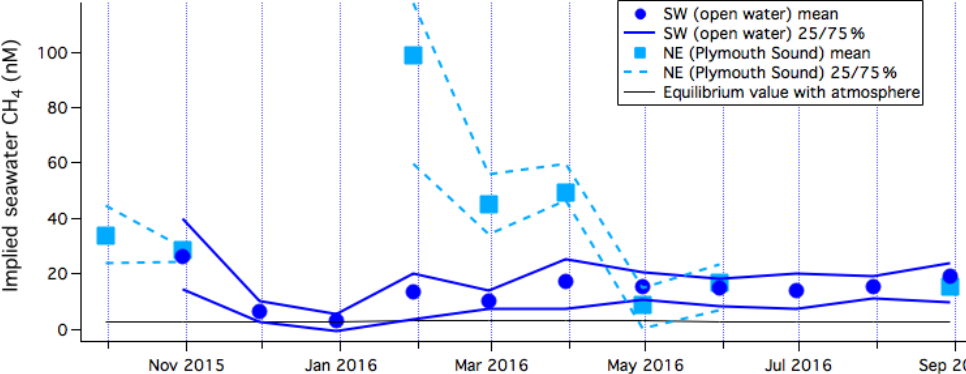
Figure 3. Monthly averages and 25th and 75th percentiles of implied CH 4 concentration for the southwest (open water) and northeast (Plymouth Sound) wind sectors, along with the equilibrium value with respect to the